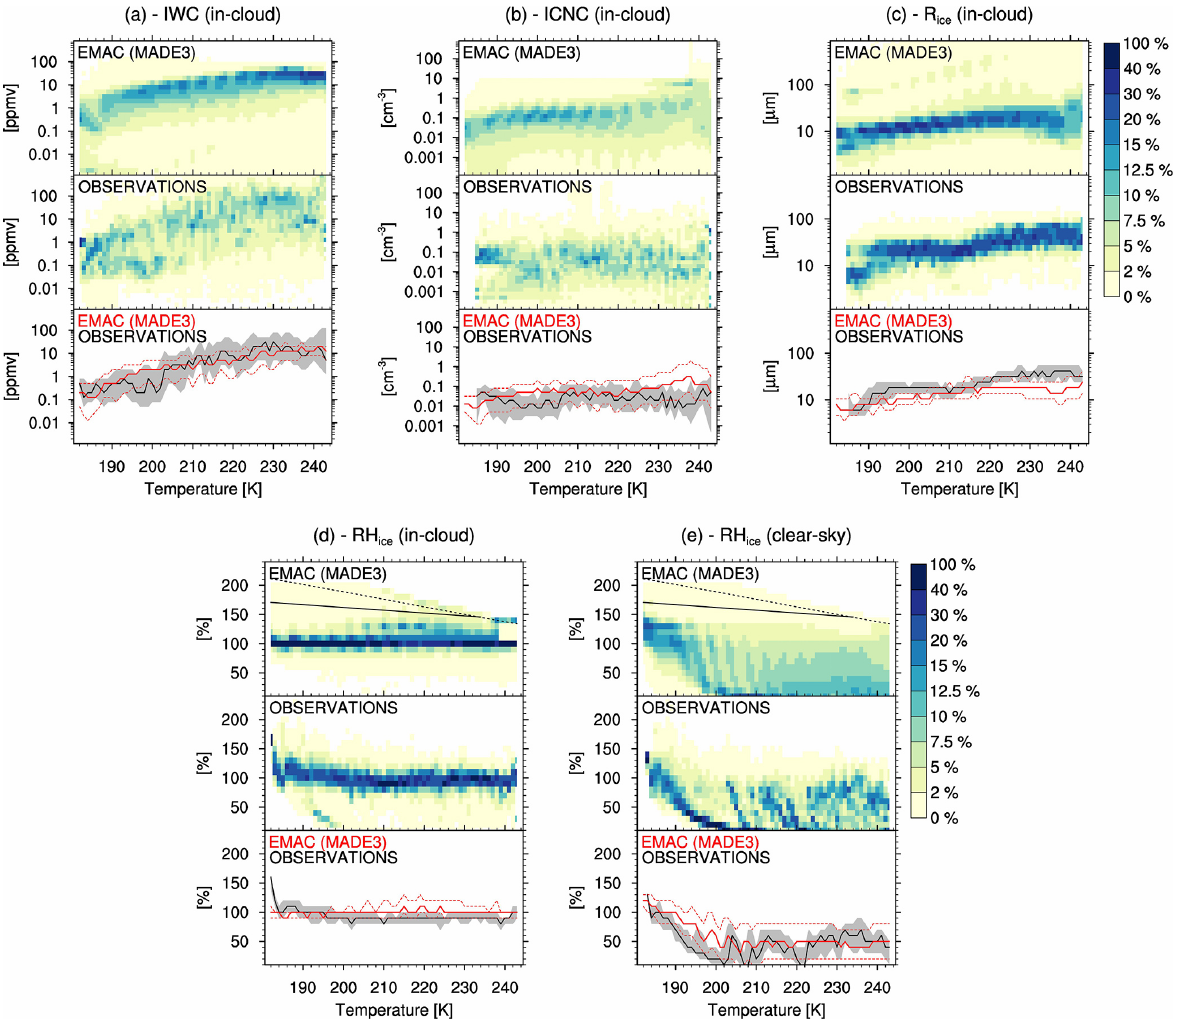
Figure 5. Climatology of various cirrus properties derived from flight campaigns as compared with EMAC (MADE3) simulations: in-cloud ice water content (a) , in-cloud ice crystal number concentration (b) , ice crystal mean-volume radius (c) , in-cloud (d) and clear-sky (e) relative humidity with respect to ice. The data are plotted as probability distribution functions in 1K temperature bins in the model (top plot in each panel) and in the observations (middle plot). The bottom plots in each panel show the median (solid red line) and the 25 / 75% quantiles (dashed red) of the model compared with the median (solid black line) and the 25 / 75% quantiles (gray shading) of the observations. The dashed and solid black lines on the relative humidity panels (d, e) represent the water saturation and the homogeneous freezing threshold (Koop et al., 2000),